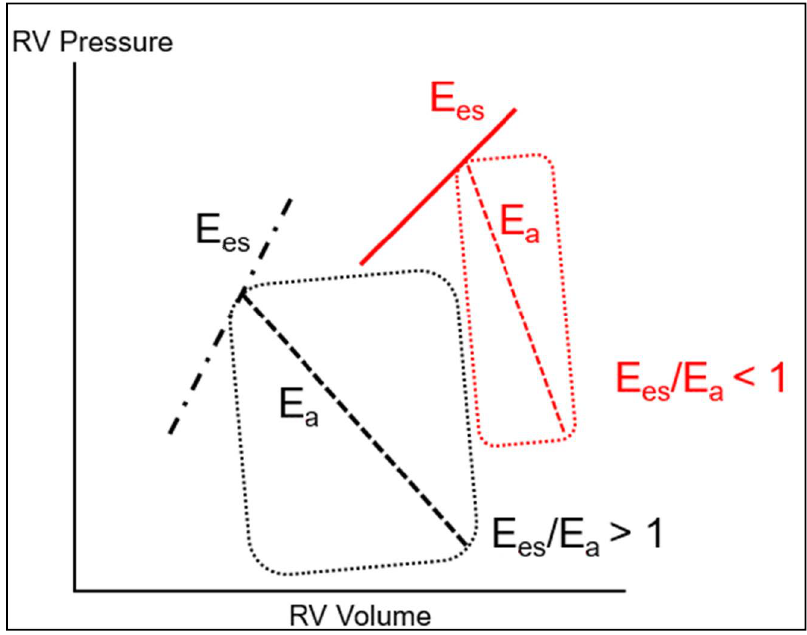
Figure 1. RV-PA coupling. The pressure volume curve of the RV allows characterization of the end-systolic PV relationship, whose slope corresponds to the RV systolic elastance (Ees), a load-independent measure of RV contractility. The line joining the RV end-systolic volume with its end-diastolic volume is termed the pulmonary arterial elastance (Ea), which is a measure of the afterload as it is seen by the RV. The ratio between Ees and Ea defines the RV-PA coupling, which should always be kept >1 for optimal RV efficiency (black lines). Increased Ea or/and reduced Ees precipitates RV uncoupling (Ees/Ea < 1). The RV must dilate (Frank–Starling mechanism) to maintain its output, at the expense of a marked increase in wall stress, hence myocardial oxygen demand (Red lines).